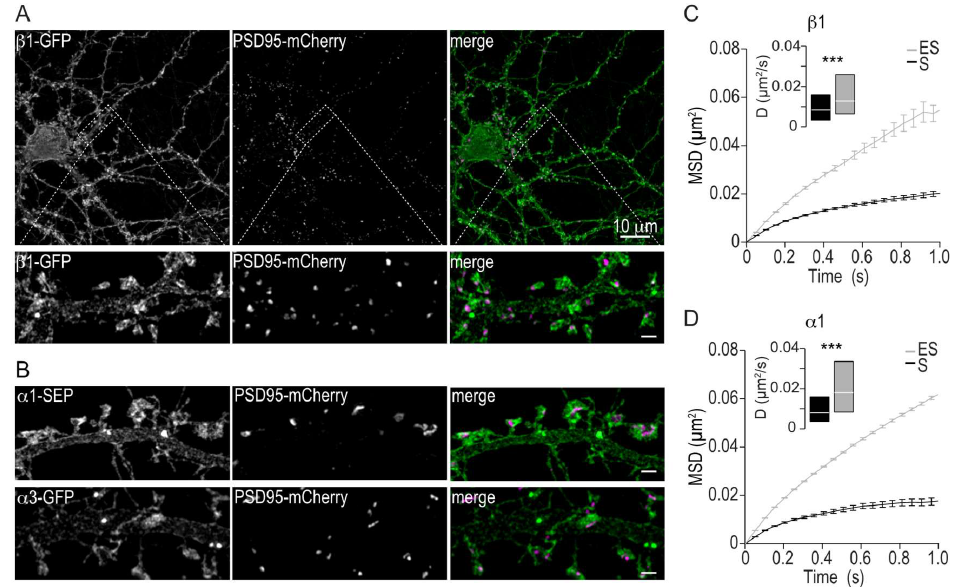
Figure 2. Comparison of α3, α1 and β1 expression and diffusion characteristics. ( A ) Maximum intensity projection of a structured illumination microscopy Z-stack through a DIV24 hippocampal neuron co-expressing β1-GFP (green) and PSD95-mCherry (magenta). Scale bar represents 10 μm. Insets, structured illumination microscopy images of the region in the white rectangle showing dendritic segments and dendritic spines co-expressing β1-GFP together with PSD95-mCherry. Scale bars represent 1 μm. ( B ) Structured Illumination Microscopy images of dendritic segments and dendritic spines co-expressing α1-SEP (top panels, green) or α3-SEP (lower panels, green) together with PSD95-mCherry (magenta). Scale bars represent 1 μm. ( C , D ) Mean ± SEM MSD plots for QD-bound β1-GFP ( C ) and α1-SEP ( D ) in the synaptic (S, black lines) and extrasynaptic (ES, grey lines) regions. Insets, median ±25–75% IQR of the QD-bound diffusion coefficients D in the synaptic (black boxes, n = 82 trajectories for α1, n = 264 for β1) and extrasynaptic (grey boxes, n = 360 trajectories for α1, n = 871 for β1) regions in cells expressing β1-GFP ( C ) or α1-SEP ( D ). *** p < 0.001 with the Mann–Whitney U test.